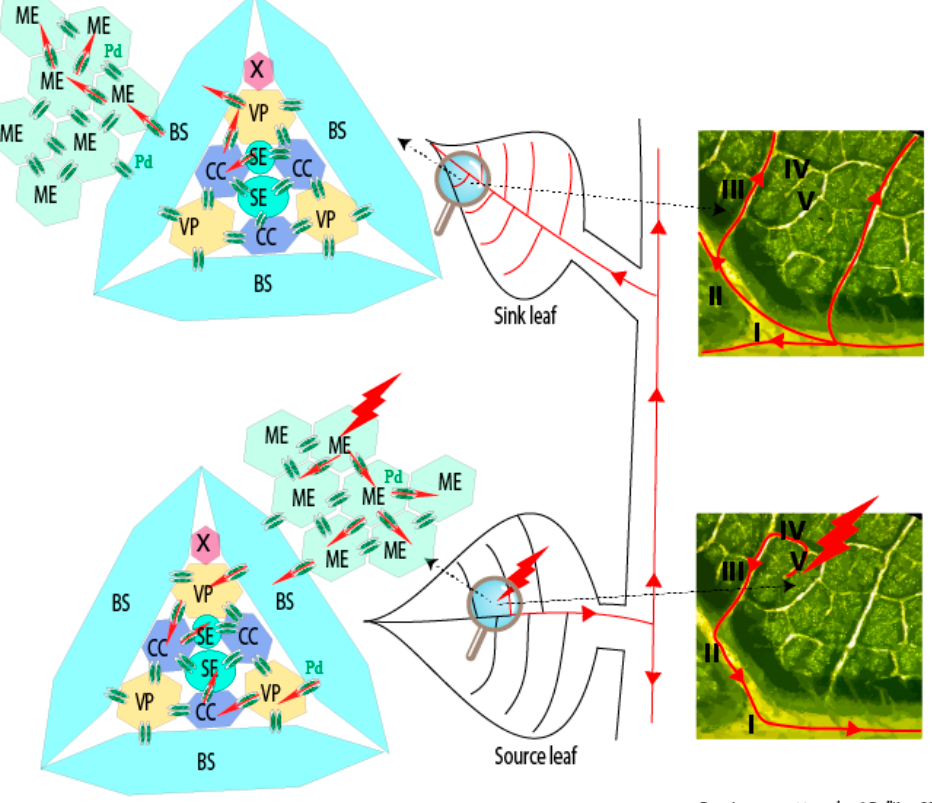
Figure 1. Schematic representation of the initial infection (red thunderbolt) and its progression (red lines and arrows) within a source leaf of an infected plant. Infectious material passes through plasmodesmata (Pd, double green ovals) from mesophyll (ME), bundle sheath (BS), vascular parenchyma (VP) to companion cells (CC) to access sieve elements (SE) and reach the distant tissues. A reverse route occurs in the upper leaves (sink leaf) or roots (not represented). Right panels show leaf venation and illustrate viral phloem loading and unloading through minor and major veins of source and sink leaves. X, Xyleme; I − V: vein